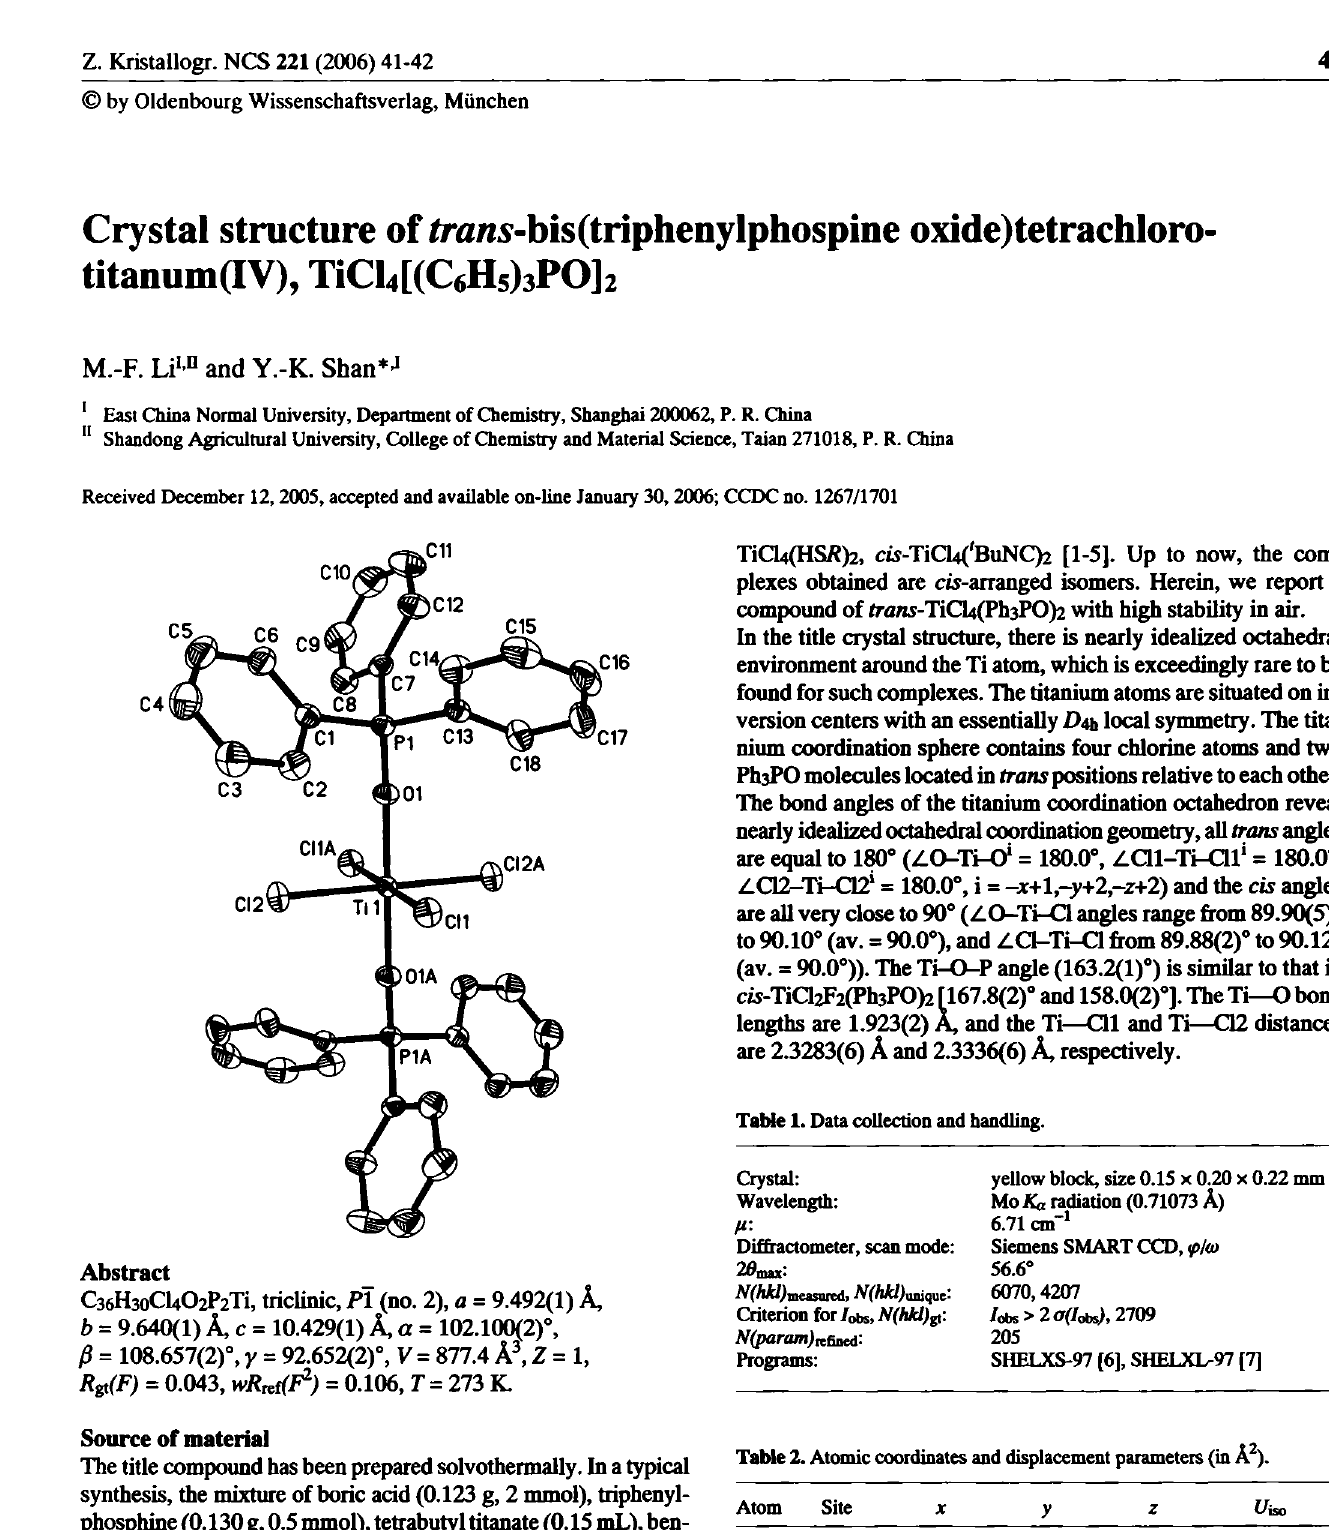
Table 2. Atomic coordinates and displacement parameters (in Ä 2